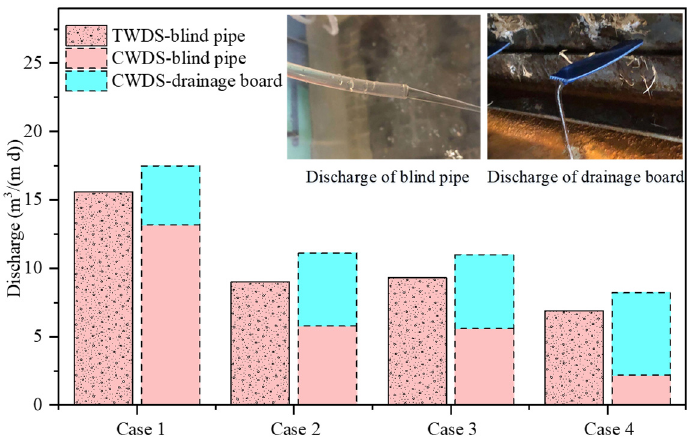
Figure 8. Test results of discharge under different working conditions.